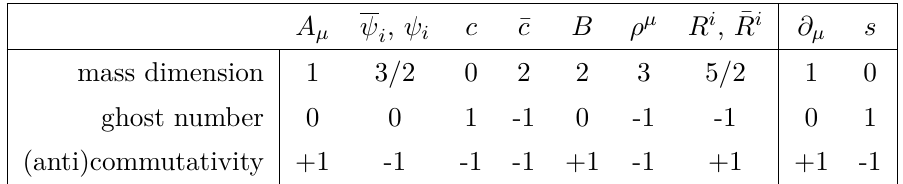
Table 1 . List of fields, external sources and operators, and their quantum numbers. are linear in the propagating fields, and one may write down identities of the form δS (4 D )